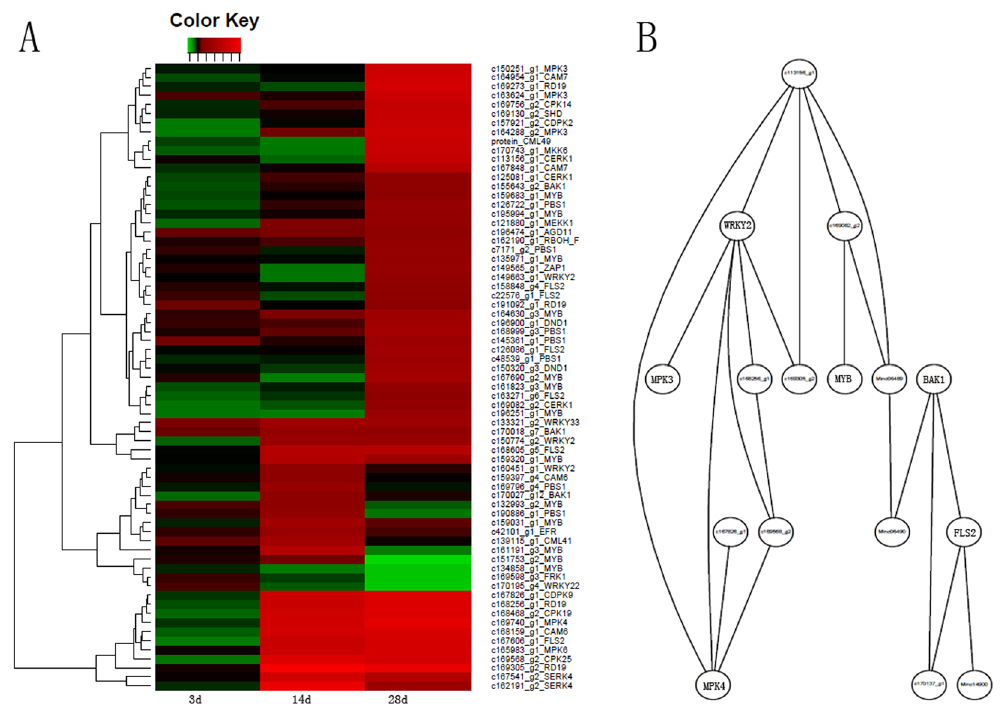
Figure 9. The expression pattern of Cm pathogen-related genes ( A ) and the co-expression of pathogen-related genes and RKN effectors. ( A ) The log2 Ratio values of Cm pathogen related DEUs were used for hierarchical cluster analysis with the R heatmap package. Red represents up-regulated unigenes, green represents down- regulated unigenes, and black indicates no significant difference in unigene expression. Details of annotated unigenes shown on the right are provided in Supplementary Table S8. ( B ) The co-expression net of Cm pathogen related DEUs and Mi effectors. The net contains Cm 13 pathogen related genes and three known RKN effectors ( Minc06489 , Min06490 and Minc14900